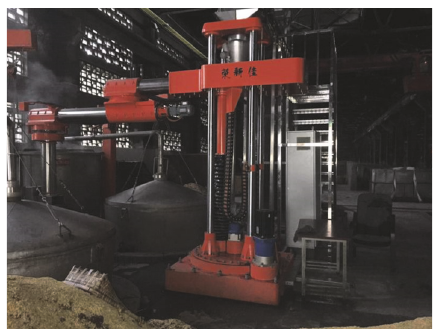
Figure 16: Steamer-filling robot used in